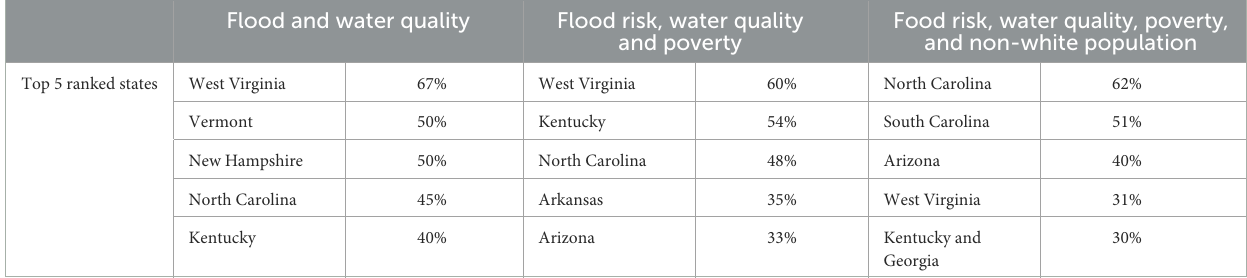
TABLE 4 Summary of results from the combinatory risk metrics considering: (1) flood and water quality; (2) flooding, water quality, and poverty; and (3) flooding, water quality, poverty, and nonwhite population. Flood and water quality Flood risk, water quality and